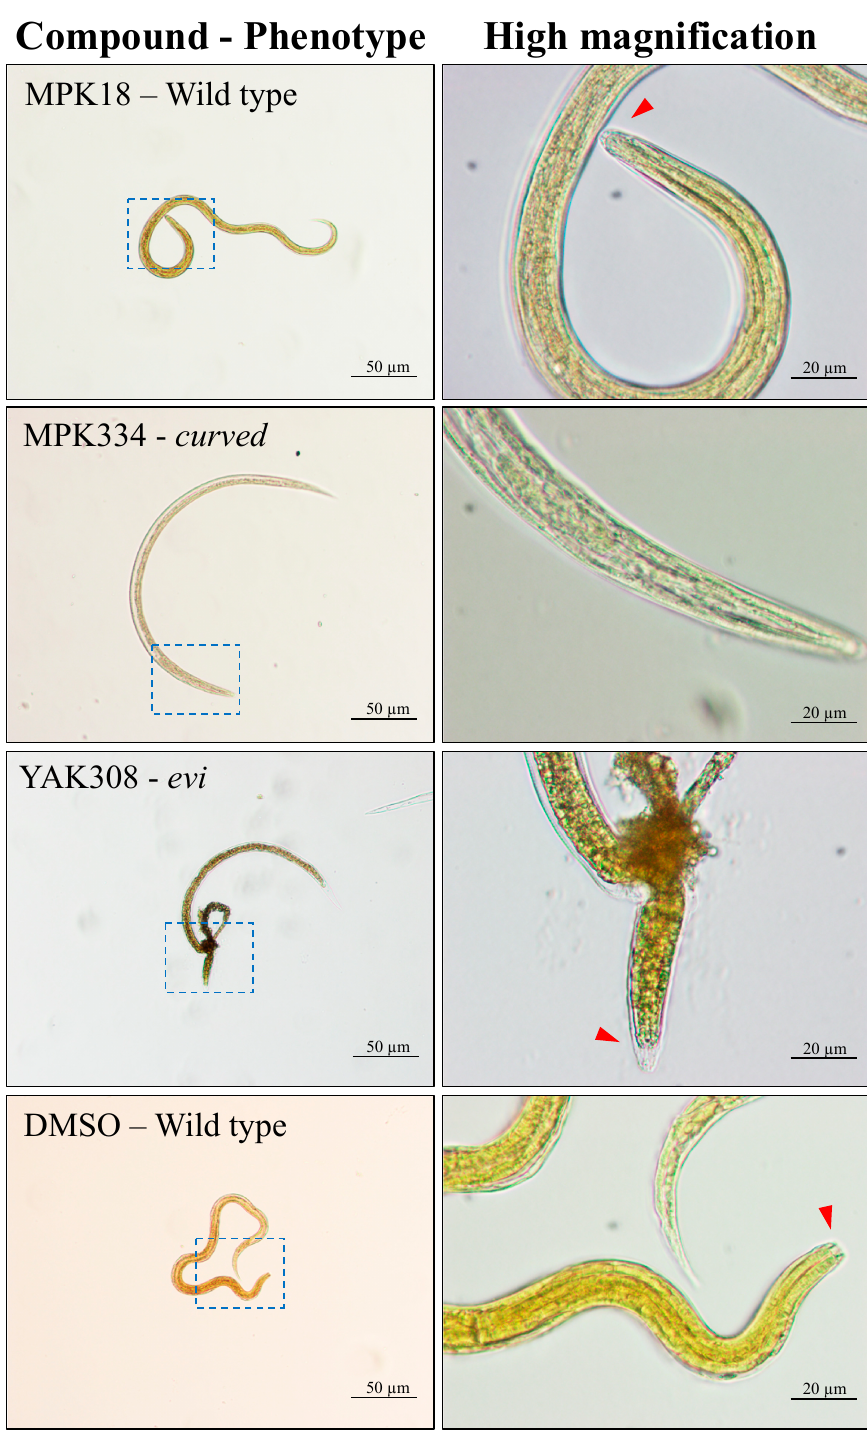
Figure 3. Micrographs of exsheathed third-stage larvae (xL3s) or fourth-stage larvae (L4s) of Haemonchus contortus exhibiting different phenotypes after exposure for 7 days to compounds (MPK18, MPK334 or YAK308) or negative control (DMSO). The representative larvae were imaged following the exposure to each of compounds at 100 µM over seven days. A section of each micrograph (blue dashed-box) under 20-times magnification (left panels) were viewed under a higher magnification (100-times magnification; right panels) for the detailed anterior region of individual larva. The L4s have a developed mouth (red arrow).